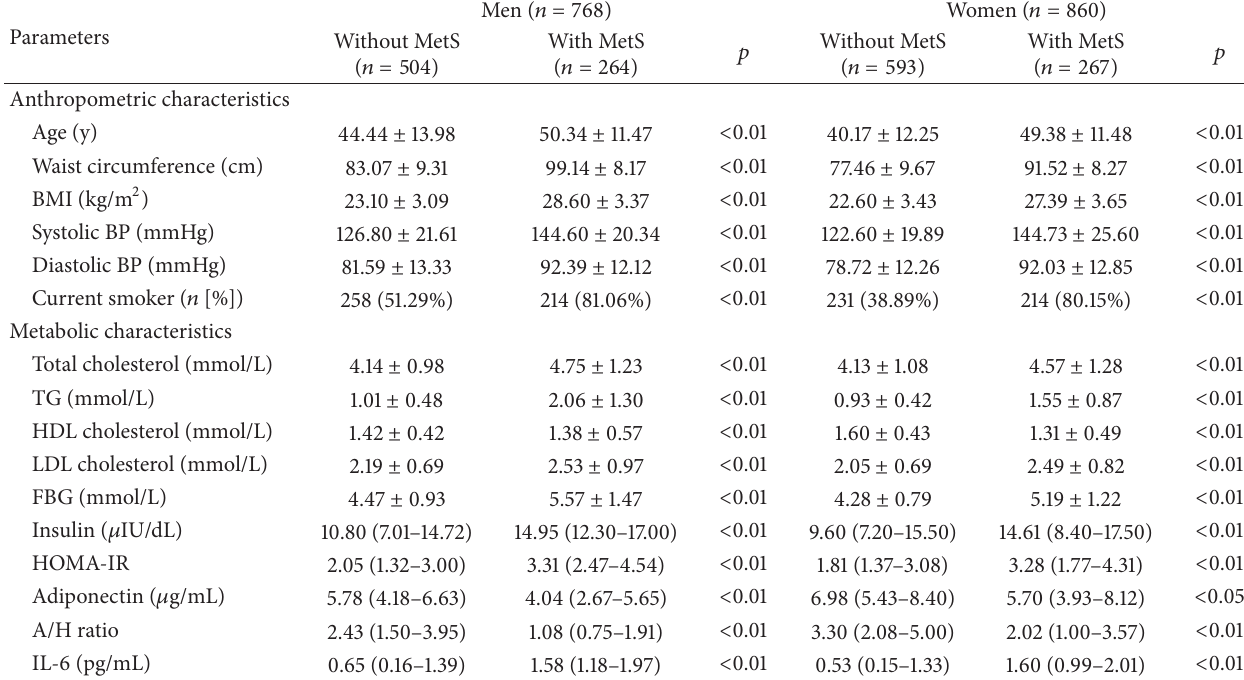
Table 1: General characteristics of the study participants according to presence or absence of